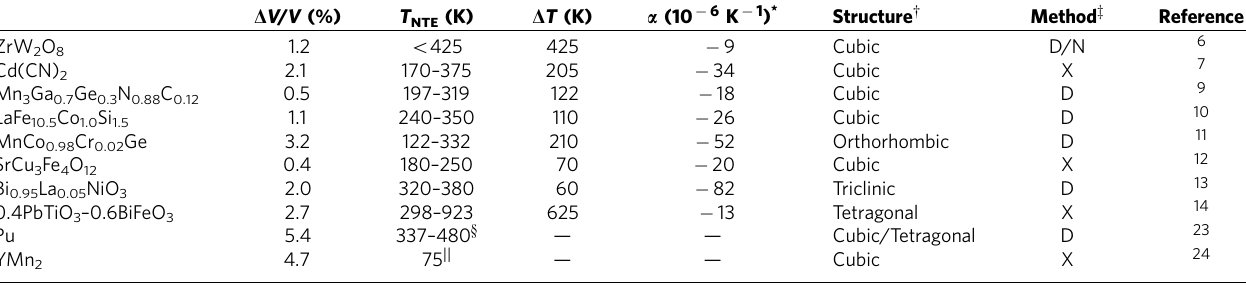
Table 1 | Parameters related to negative thermal expansion for recently discovered giant negative thermal-expansion materials.